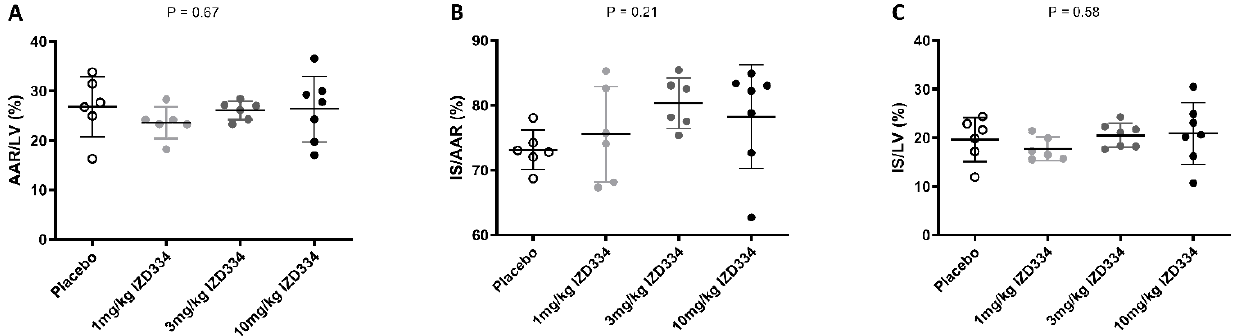
Figure 6. Myocardial infarct size. Normal distribution of data was confirmed as described in our methods (using Shapiro–Wilk test). Hence, a one way-ANOVA was performed. ( A ) The area at risk as a ratio of the left ventricle (AAR/LV) was similar in all treatment groups (placebo 26.8 ± 6.1%, 1 mg/kg IZD334 23.5 ± 3.2%, 3 mg/kg IZD334 26.0 ± 1.9%, 10 mg/kg IZD334 26.4 ± 6.6%, ANOVA, p = 0.67) groups ( p = 0.67). ( B ) The infarct size (IS) was not different between treatment groups when expressed relative to measurements of the ischemic AAR (placebo 73.1 ± 3.0%, 1 mg/kg IZD334 75.5% ± 7.3%, 3 mg/kg IZD334 80.3 ± 3.9%, 10 mg/kg IZD334 78.2% ± 8.0%, ANOVA p = 0.21). ( C ) IS as percentage of the LV did not differ (placebo 19.6 ± 4.5%, 1 mg/kg IZD334 17.7 ± 6.3%, 3 mg/kg IZD334 20.5 ± 2.2%, 10 mg/kg IZD334 19.3 ± 2.9%, ANOVA p = 0.58). N.B. In one pig of the 3 mg/kg group, it was not possible to measure the AAR due to a failure to infuse Evans Blue in the coronary arteries. Therefore, only in 6 pigs could the AAR and the IS/AAR be shown.